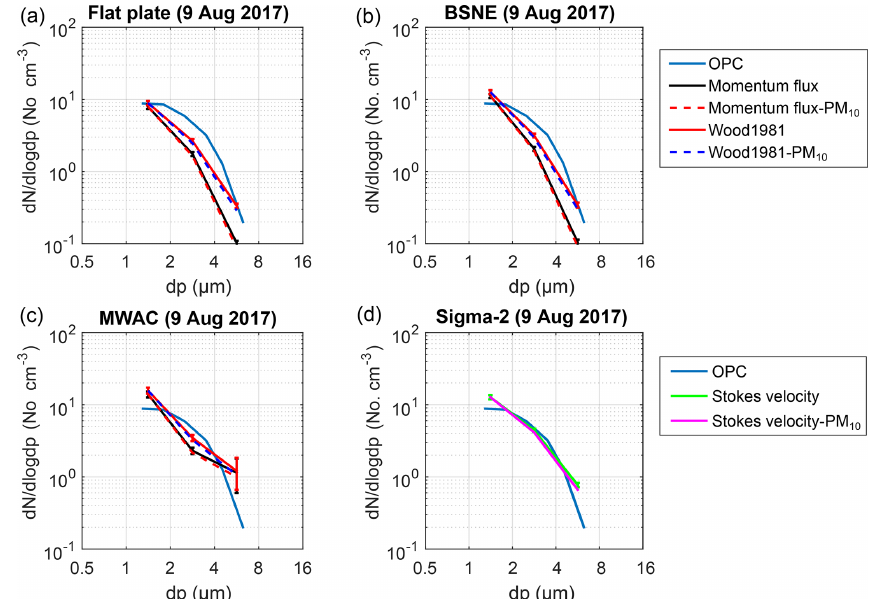
Figure 11. Comparison of the number concentrations calculated from the deposition measurements with the number concentrations measured by the OPC. Number size distributions are obtained by converting the SEM number deposition rates to number concentrations using the different deposition velocity models (Table 1), in analogy to the mass size distributions. For the concentrations obtained from the number deposition rates, two different approaches for the friction velocity are shown. The black curve shows the concentration curve calculated using the momentum flux approach without PM 10 inlet correction (i.e., the atmospheric concentration). The red curve shows the concentration curve calculated using the Wood approach without PM 10 correction. The dotted blue curve shows the concentration curve calculated using the Wood approach with PM 10 inlet correction (simulating the concentration the OPC would supposedly measure). The dotted red curve shows the concentration curve calculated using the momentum flux approach with PM 10 inlet correction. In the case of Sigma-2, the green curve shows the concentrations calculated using the Stokes velocity and the magenta curve the ones using Stokes velocity with the PM 10 inlet correction. The bars show the central 95% confidence interval of the daily variation. (a) Flat plate; (b) BSNE; (c) MWAC; (d) Sigma-2. The average wind speed on 9 August 2017 was 3.0ms − 1 . Note that panel (d) refers to the second legend.